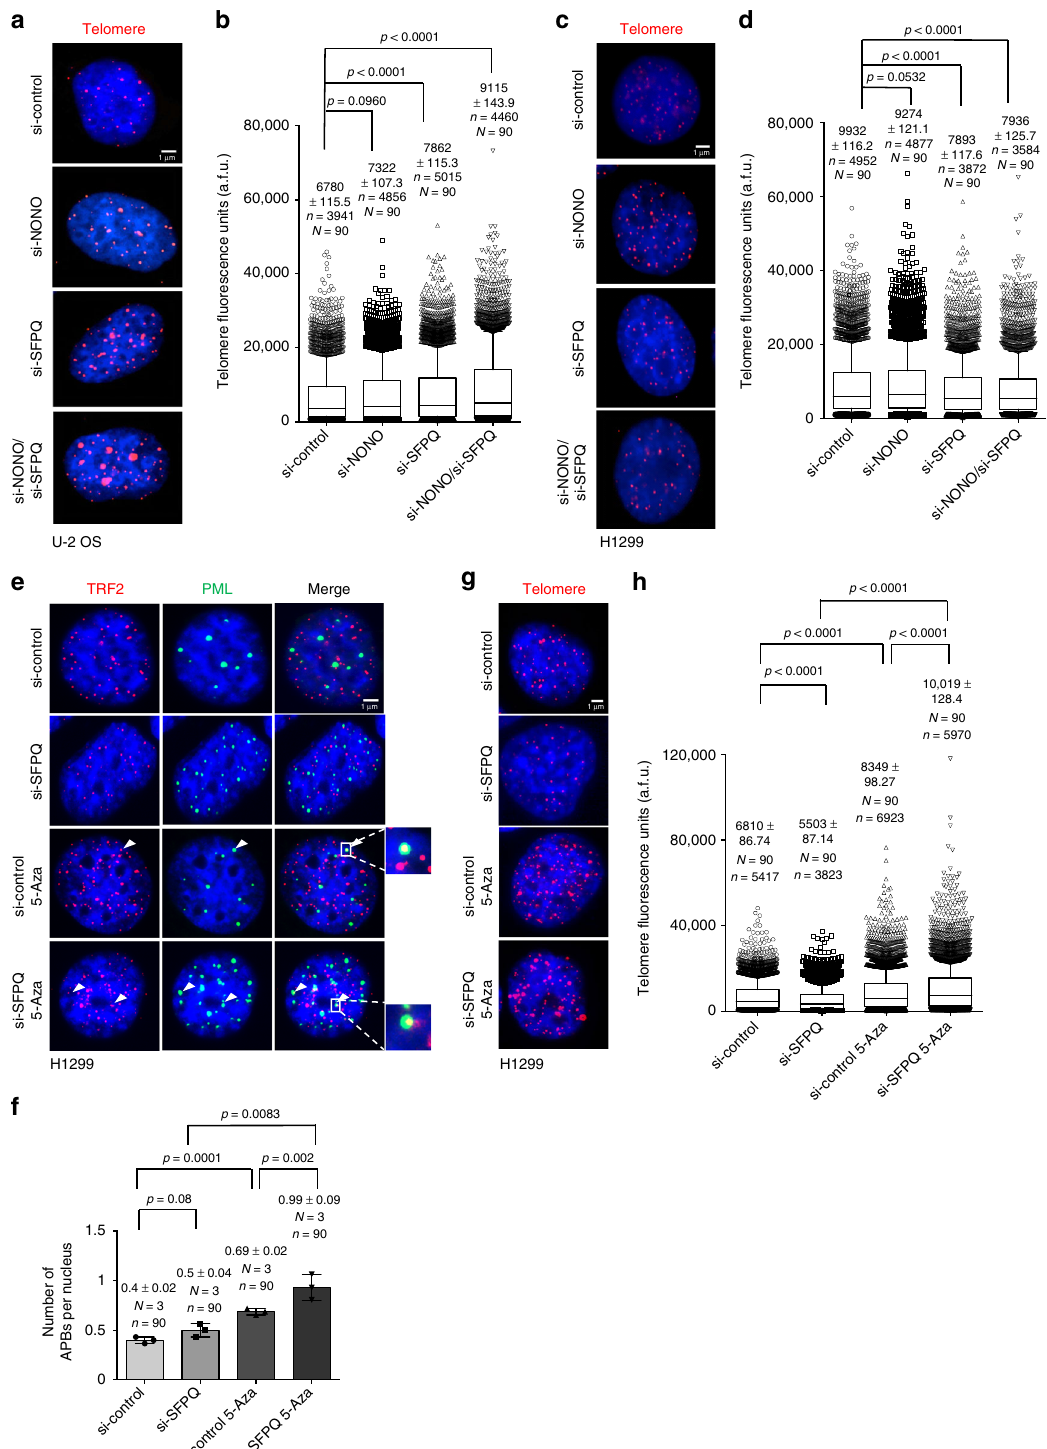
and T-SCE in SFPQ loss of function cells 50 . This suggests that telomere